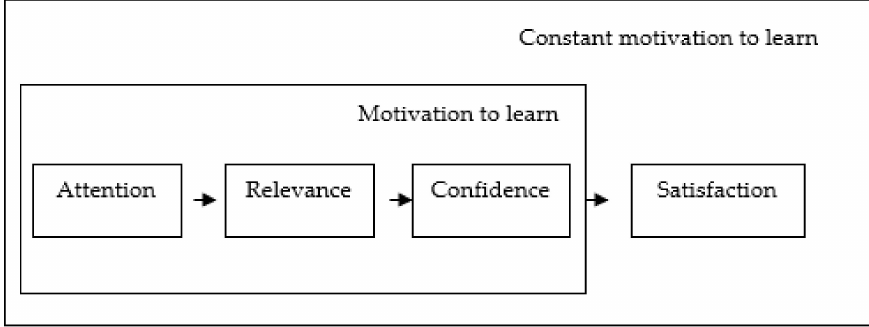
Figure 6. Keller’s ARCS (Attention, Relevance, Confidence, Satisfaction) model (Keller, 1983)